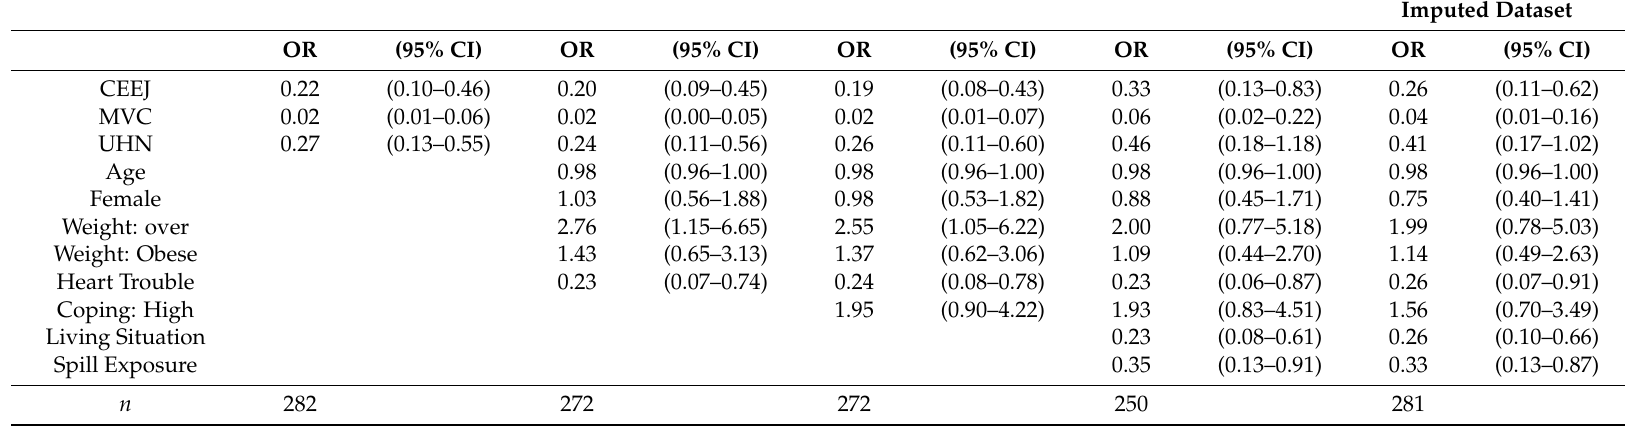
Table 2. Logistic regression predicting odds of reporting good to excellent health following the oil spill among adults 18 years and older in the GC-HARMS sample.